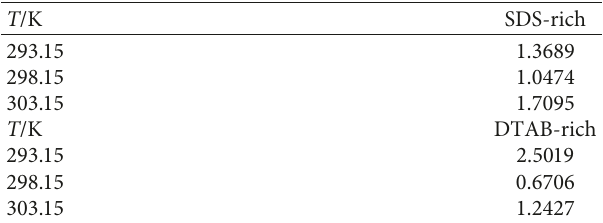
Table 11: Intrinsic viscosity ( η ) of SDS-rich and DTAB-rich surfactants in the aqueous medium at the three different tem- peratures T � 293.15, 298.15, and 303.15K and at 0.1MPa.